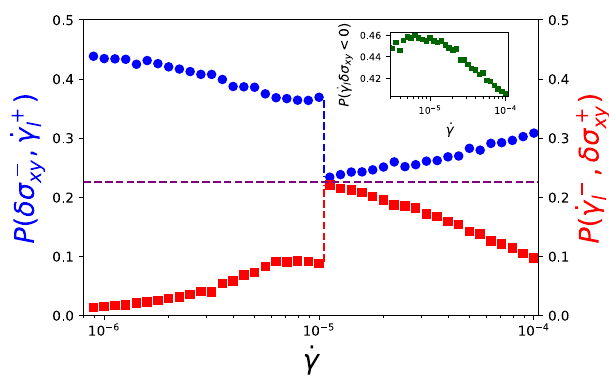
Fig. 3 Decomposition of probabilities of negative power. Inset: probability of negative power, P ð δσ xy _ γ l < 0 Þ where P is the net probability, δσ xy is the stress difference, and _ γ l is the local shear rate de fi ned by Eq. (12), as a function of the global shear rate, _ γ . A power equal to δσ xy _ γ l > 0 must be dissipated; however, in a negative event this power is given up by the subsystem, δσ xy _ γ l < 0. In the thickened phase, P ð δσ xy _ γ l < 0 Þ decreases monotonically with increasing the shear rate. No discontinuity is observed at the critical shear rate. Main panel: because _ γ P ð δσ Þ ¼ P ð δσ (cid:2) ; _ γ þ Þ þ P ð _ γ (cid:2) ; δσ þ Þ , Eq. (3), we calculate P ð δσ (cid:2) ; _ γ þ Þ , xy xy xy xy l < 0 l l l the probability for negative power due to negative stress difference, and P ð _ γ (cid:2) ; δσ þ Þ , the probability for negative power due to negative local strain xy l rate, directly from our raw data to see if they can be decomposed into two separate curves. Joint probabilities P ð δσ (cid:2) xy ; _ γ þ l Þ and P ð _ γ (cid:2) l ; δσ þ xy Þ are displayed by the blue circles and red squares, respectively. Notably, a decomposition of the joint probabilities into a mirror-image curve has been found. Whereas P ð δσ (cid:2) xy ; _ γ þ l Þ is reduced almost twice at _ γ c ¼ 10 (cid:2) 5 , and then increases as a function of the shear rate, P ð _ γ (cid:2) l ; δσ þ xy Þ is enhanced by the same rate, and it decreases with the shear rate in the fl uid phase. At _ γ ¼ _ γ c , P ð δσ (cid:2) ; _ γ þ Þ ¼ P ð _ γ (cid:2) ; δσ þ Þ which is marked by the horizontal purple dashed xy xy l l line. Error bars are smaller than symbols. The packing fraction is ϕ = 0.81, and the number of particles is N =